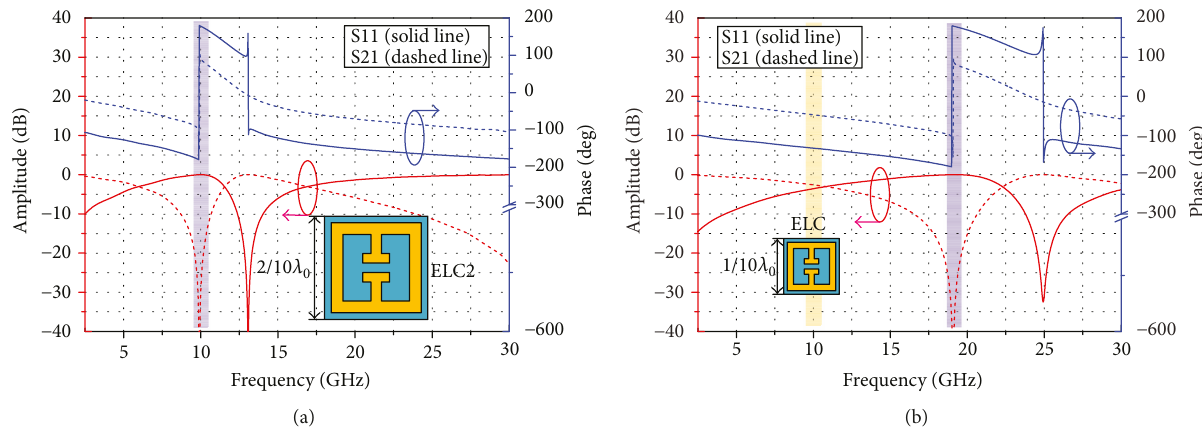
= 0 43mm , and w = 0 6 mm . s